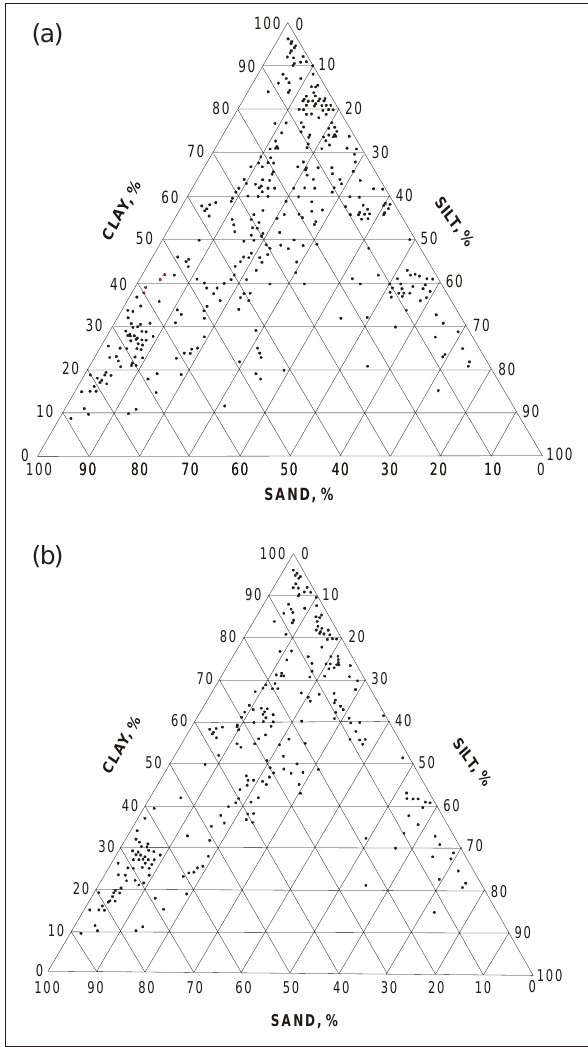
Figure 1. Plots of the soils by their texture (particle size distribution): (a) all samples, (b) samples of A and B horizons of Ferralsols.